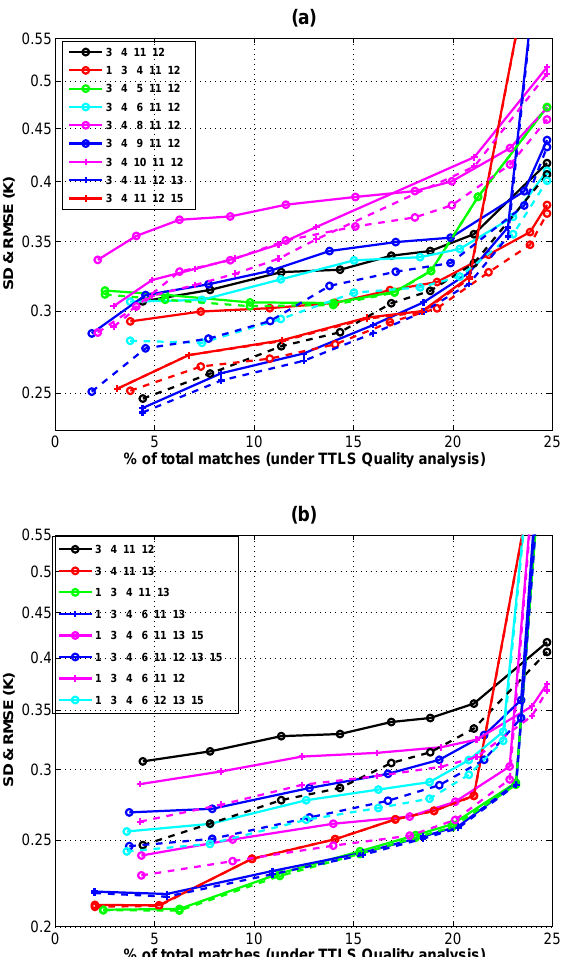
Figure 1. ( a , b ) Retrieval results of TTLS under TTLS QI for different combinations of channels selection. Solid lines stand for RMSE (root mean square error) and dashed lines stand for SD (standard